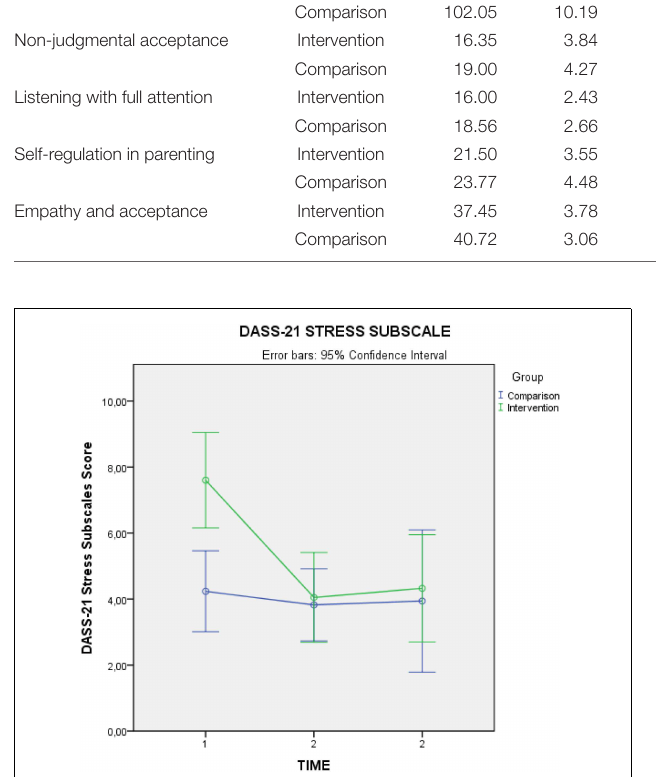
FIGURE 2 | DASS-21 stress subscale marginal pre, post, and follow-up means.